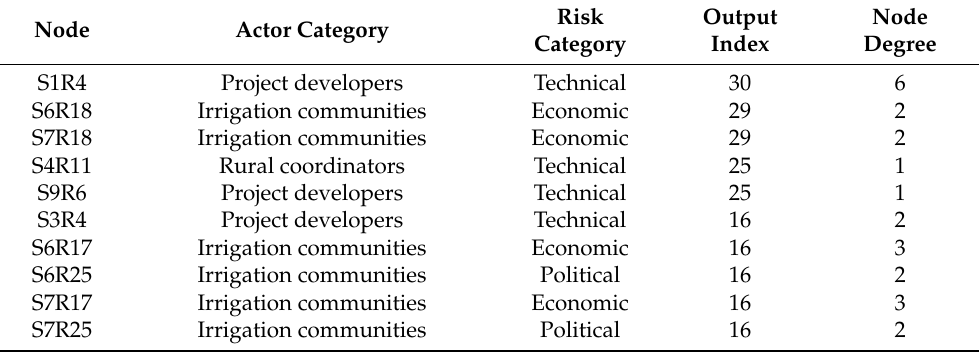
Table 5. Centrality results by output